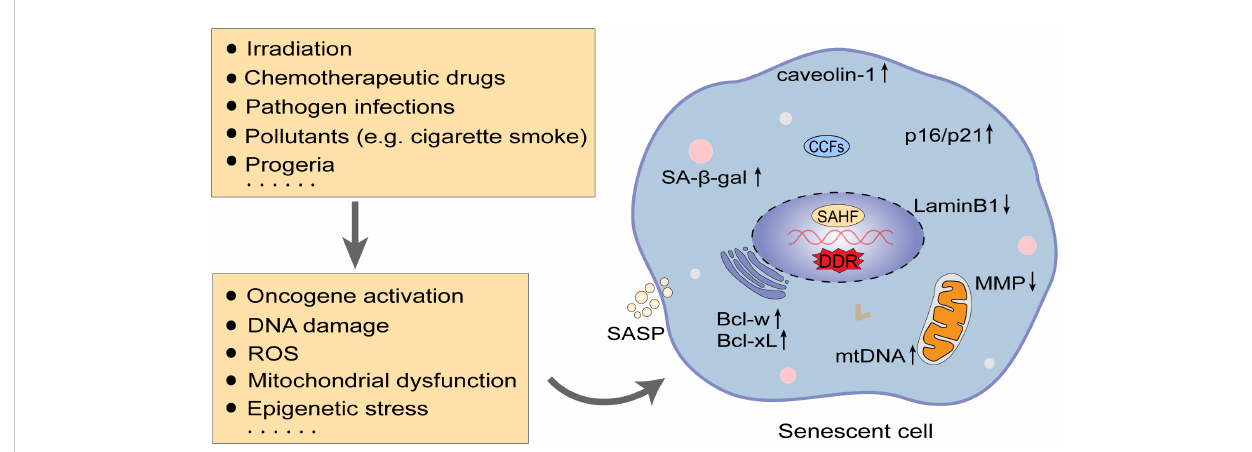
FIGURE 1 Inducing factors and characteristics of senescence. In addition to replicative senescence induced by telomere shortening, numerous factors such as irradiation, chemotherapeutic drugs, and pathogenic infections can evoke senescence by impacting oncogene activation, DNA damage, mitochondrial dysfunction, etc. DNA damage response (DDR) is an essential mechanism in triggering senescence. Cellular senescence features altered cell morphology and structure, arrest of the cell cycle (upregulation of p16/p21), and enhanced resistance to apoptosis (upregulation of Bcl- xL and Bcl-w), along with detectable nuclear senescence-associated heterochromatin foci (SAHFs), increased senescence-associated b - galactosidase (SA- b -gal) activity, and secretion of senescence-associated secretory phenotype (SASP). ROS, reactive oxygen species; MMP, membrane potential; CCFs, cytoplasmic chromatin fragments; mtDNA, mitochondrial